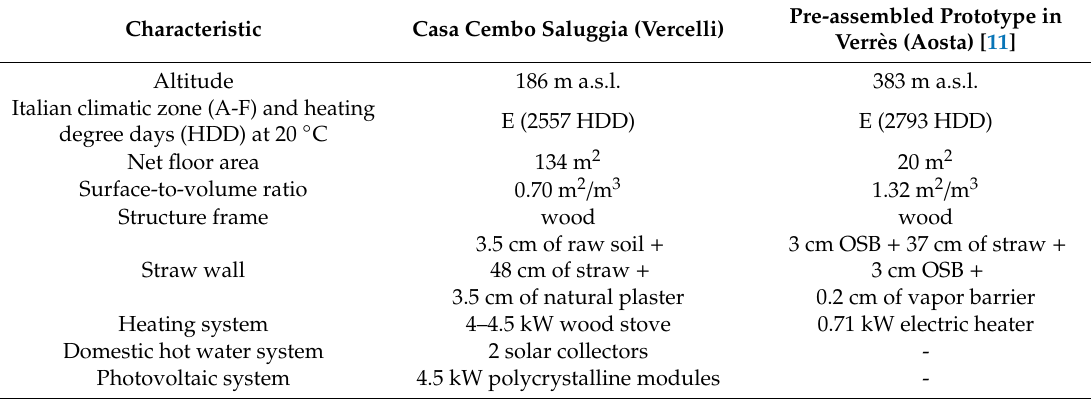
Table 2. Main features of the two case studies (OSB = oriented strand board).